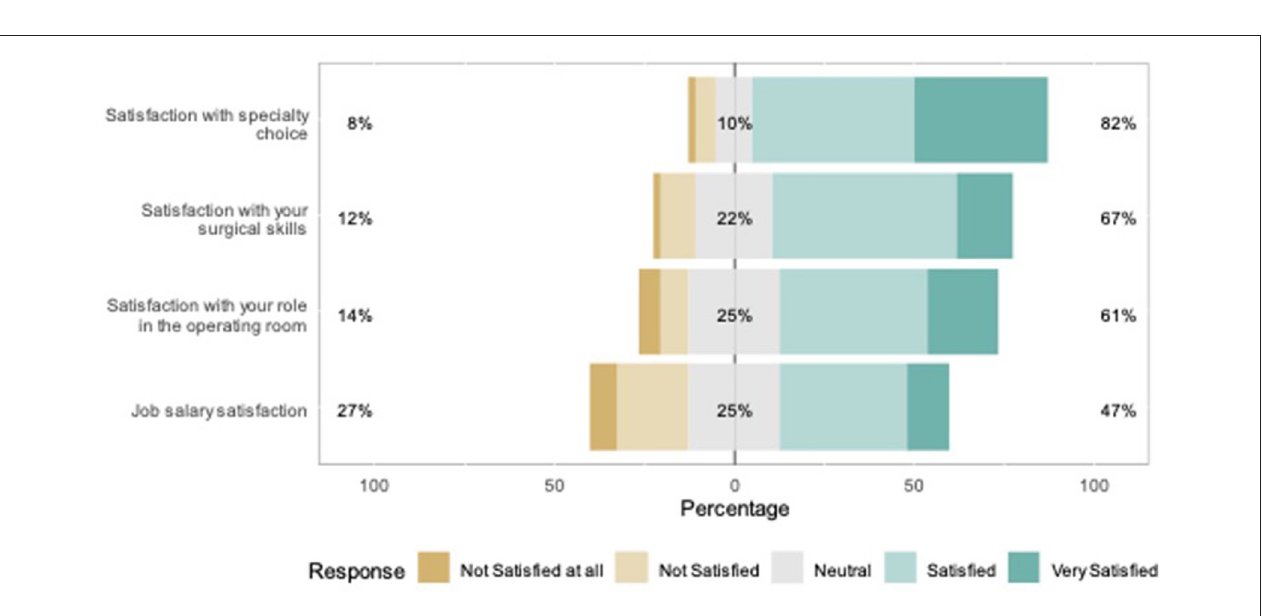
FIGURE 2 | Satisfaction with various aspects of work.